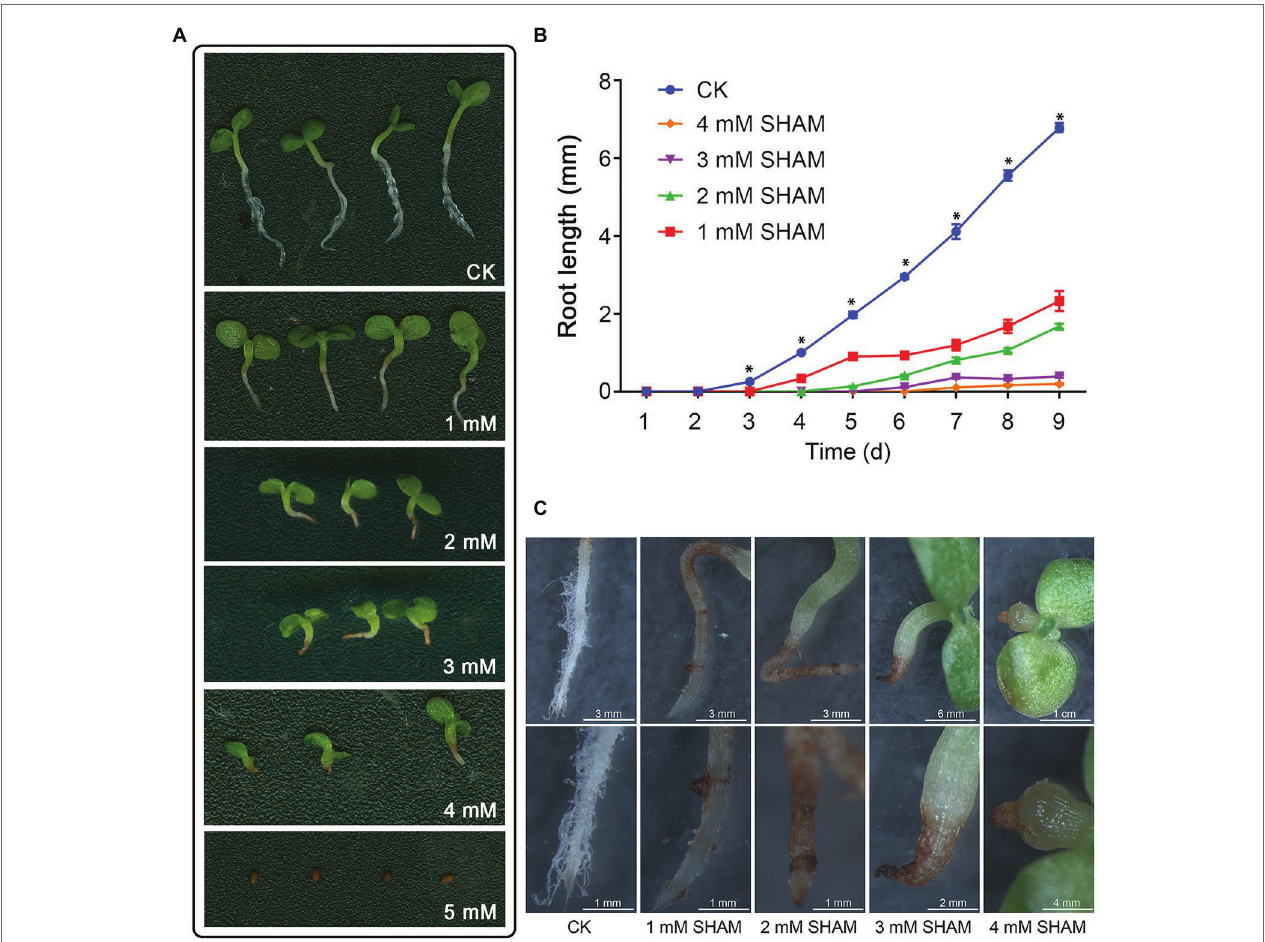
FIGURE 1 | Effects of salicylhydroxamic acid (SHAM) treatment on root formation of tobacco. (A) Comparison of tobacco root development under normal conditions (CK) and different concentrations of SHAM. (B) Comparison of root length in the absence (CK) and presence of SHAM treatments. The data are the means ± SD of three independent experiments from at least 30 seedlings. The significant differences between the SHAM-treated samples and the control samples are denoted by asterisks, ∗ p < 0.05. (C) Microscopic comparison of root phenotypes in the absence (CK) and presence of SHAM treatments. Seedlings on 8th day of growth were used for observation and